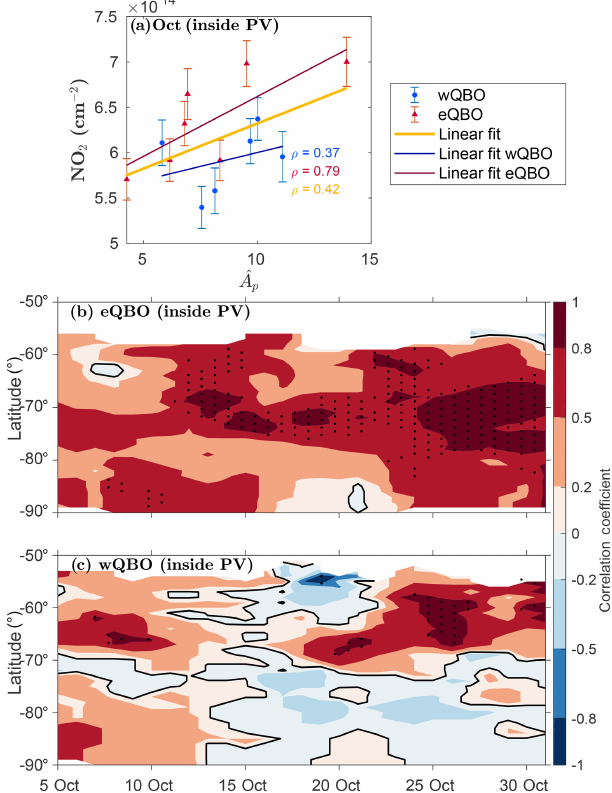
Figure 6. Vortex edge identification based on the OMI ozone column for 19 October 2014. Panel (a) shows the OMI mea- sured ozone column density with the 245DU contour highlighted. Panel (b) shows the NO 2 stratospheric column with the 245DU ozone contour highlighted. This method is repeated for each indi- vidual day in October throughout the study period.